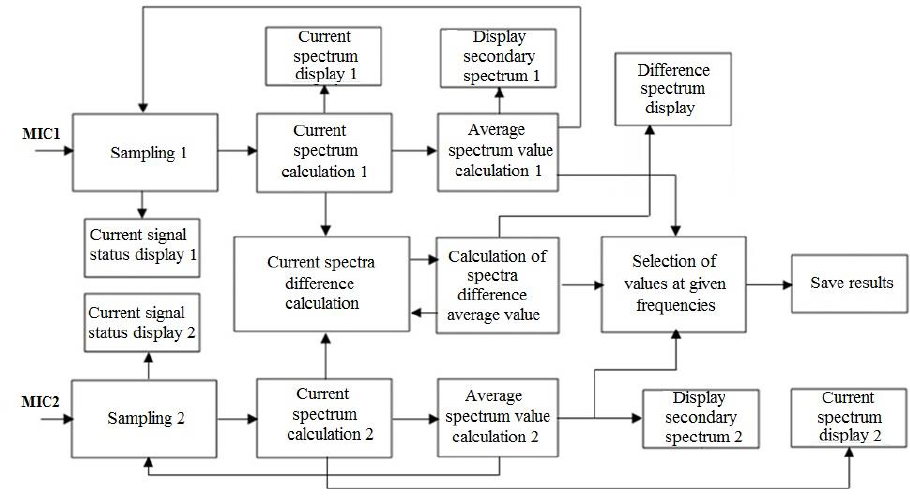
Fig. 1. Block diagram of a two-channel